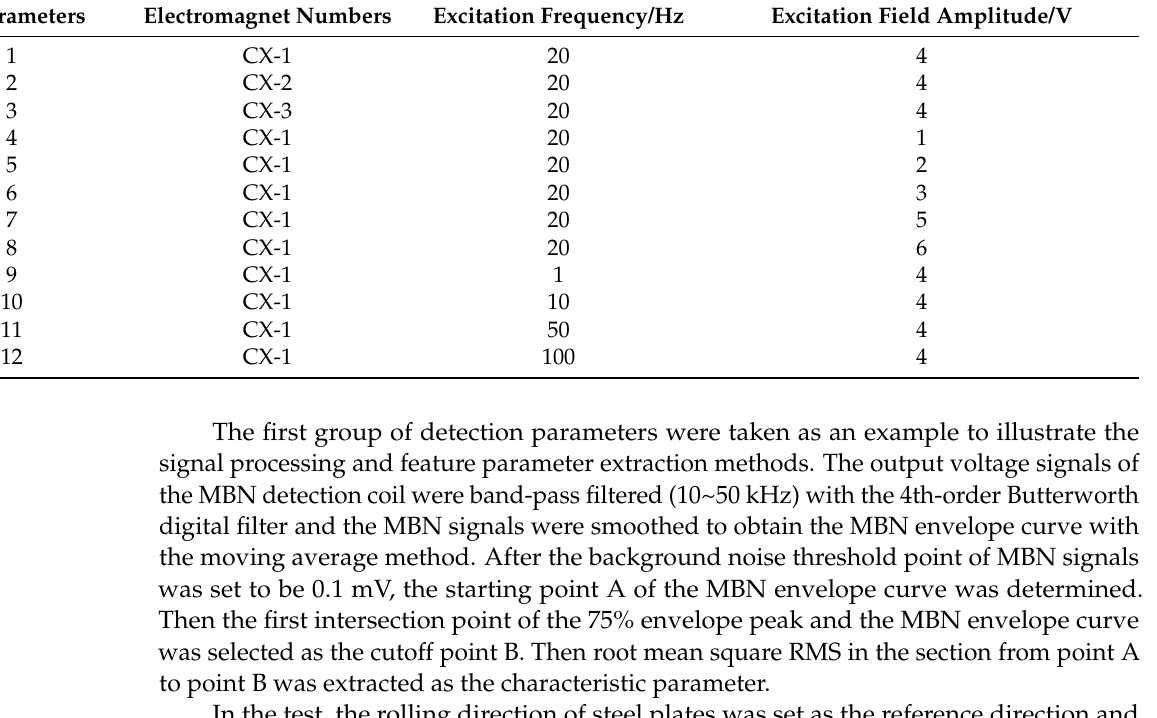
Figure 11. Optical micrographs of the microstructures of 4 materials: ( a ) 30SQG120, ( b ) B50A470, ( c ) X60, and ( d ) X70. The microstructures of B50A470 non-oriented silicon steel, X60 and X70 pipeline steel showed a random distribution pattern (Figure 11), indicating that the microstructures of these three materials did not affect their anisotropy. However, in 30SQG120 oriented silicon steel, the grains were elongated obviously along the rolling direction to form a ( a )